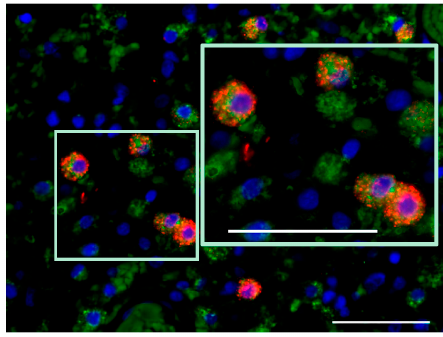
Figure 3. Microglia/macrophage (CD68 + ) phenotype of iNOS-expressing cells in the second tumor recurrence (two months after H-1PV treatment of the first recurrence). CD68, green; iNOS, red; DAPI, blue. Scale bars: 50 μ m.